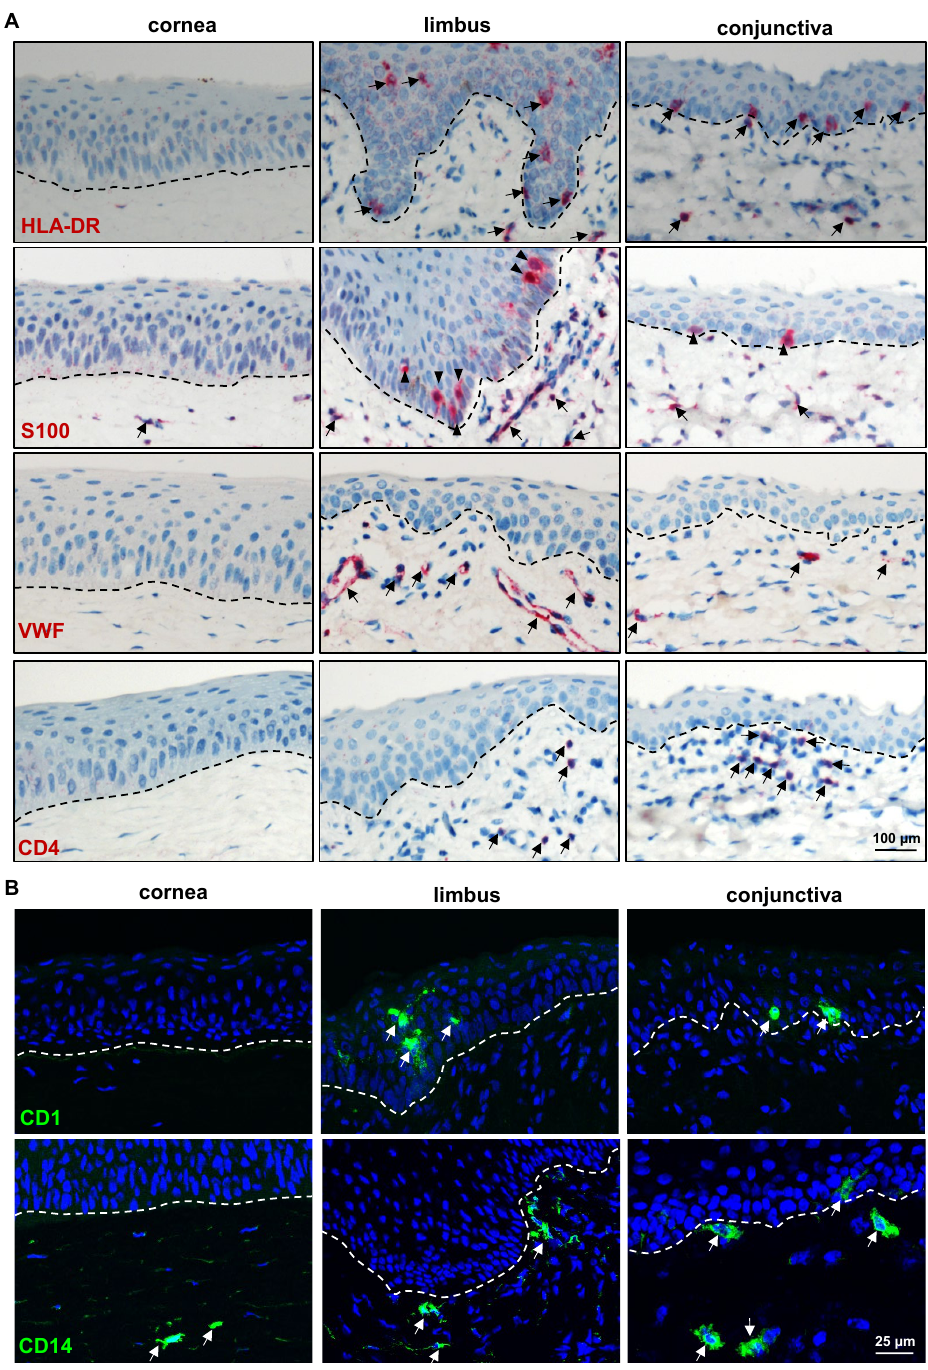
surface (dashed line represents BM).